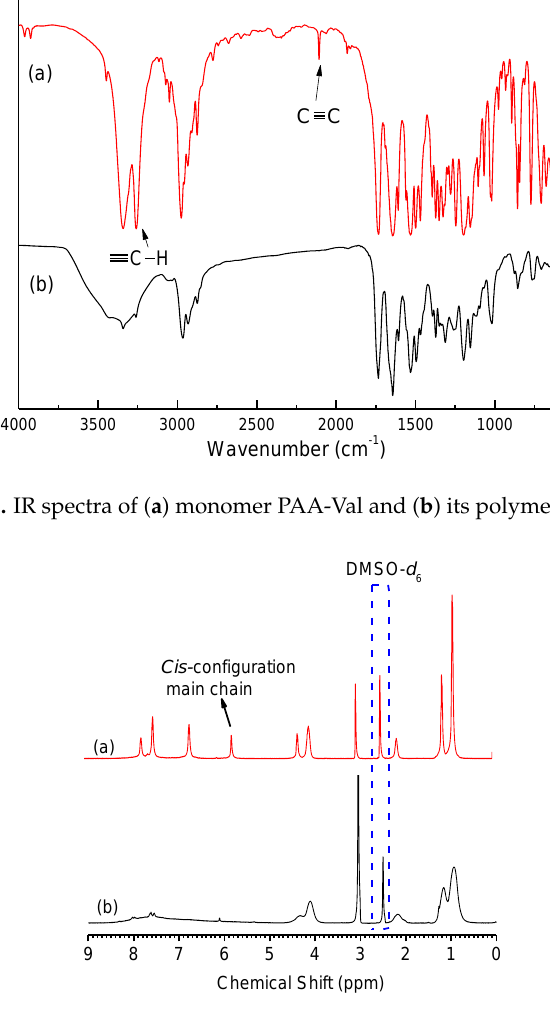
Figure 2. 1 H-NMR spectra of ( a ) PPAA-Val and ( b ) PPAA-Val-H in DMSO- d 6 at 80 °C (the polymers are soluble in DMSO- d 6 at 80 °C).